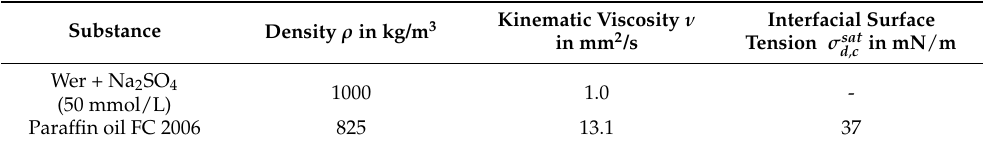
Table 2. Physical properties of the